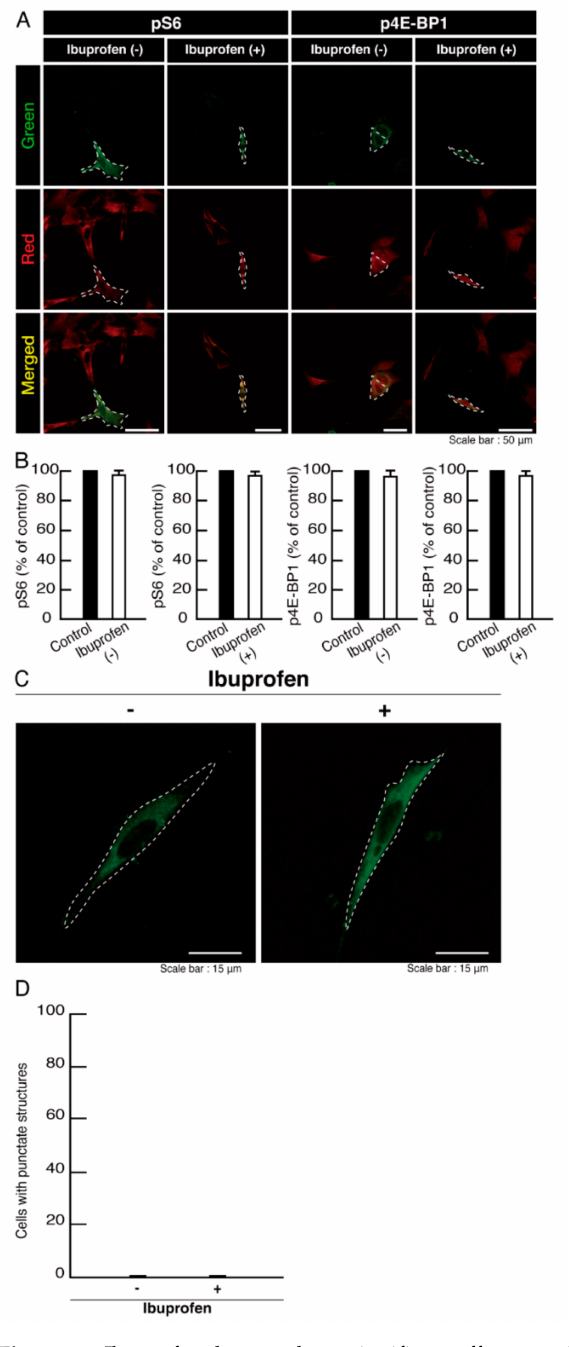
Figure 14. Ibuprofen does not have significant effects on phosphorylation levels of ribosomal S6 and 4E-BP1 proteins and aggregate-like punctate structures in cells harboring the wild type POLR3A. ( A , B ) FBD − 102b cells harboring the wild type (green) in the presence or absence of ibuprofen were stained with an anti-(pS240 and pS244) ribosomal S6 protein (pS6) or anti-(pT37)4E-BP1 (p4E-BP1) antibody (red). Their phosphorylation levels are shown statistically compared to those in their respective control cells under each image ( n = 3 fields). ( C , D ) Cells were treated with or without ibuprofen. Percentages of cells with punctate structures were statistically assessed ( n = 3 fields). Ibuprofen has many effects on cells. It is well established that ibuprofen suppresses the production of prostaglandins and that it exhibits antipyretic and analgesic effects by inhibiting cyclooxygenases, similarly to other NSAIDs [14]. In order to examine whether inhibition of cyclooxygenases is associated with the effect of ibuprofen on